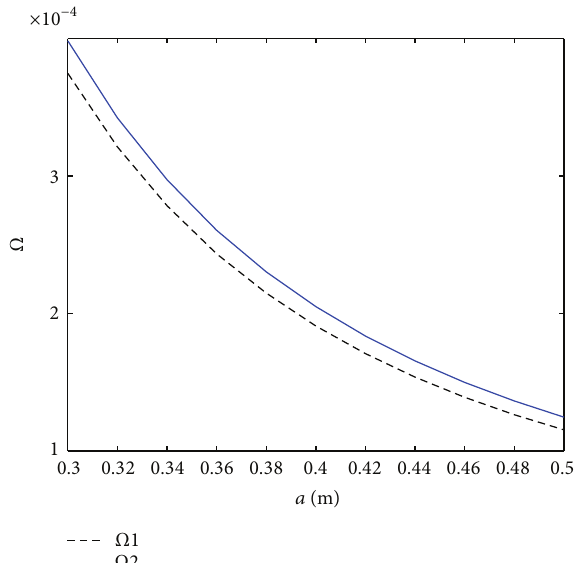
Figure 3: Variation of the first and second mode natural frequencies with the radius of the plate ( 𝑏 = 0.05 m and ℎ 𝑐 = 0.0005 m).